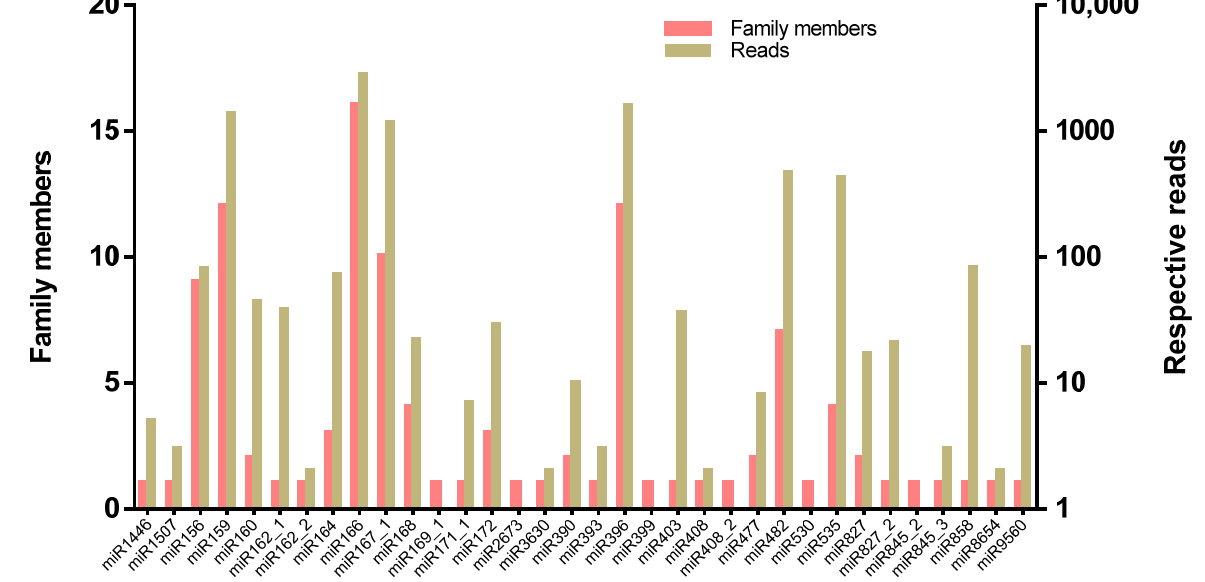
Table 2. Summary of M. koenigii conserved miRNAs.